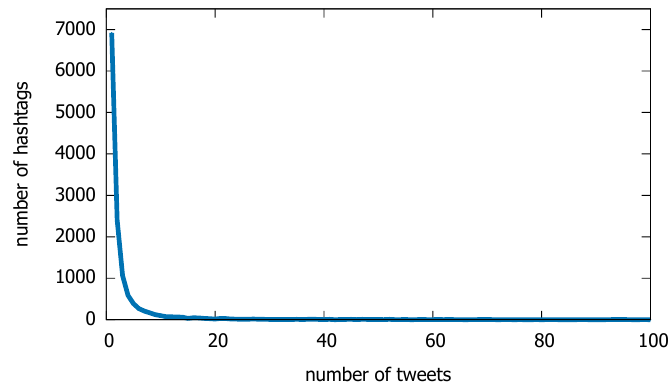
Figure 9. The distribution of the number of tweets for each hashtag.